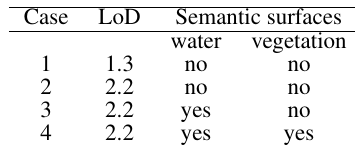
Table 1. Different wind simulations performed within the